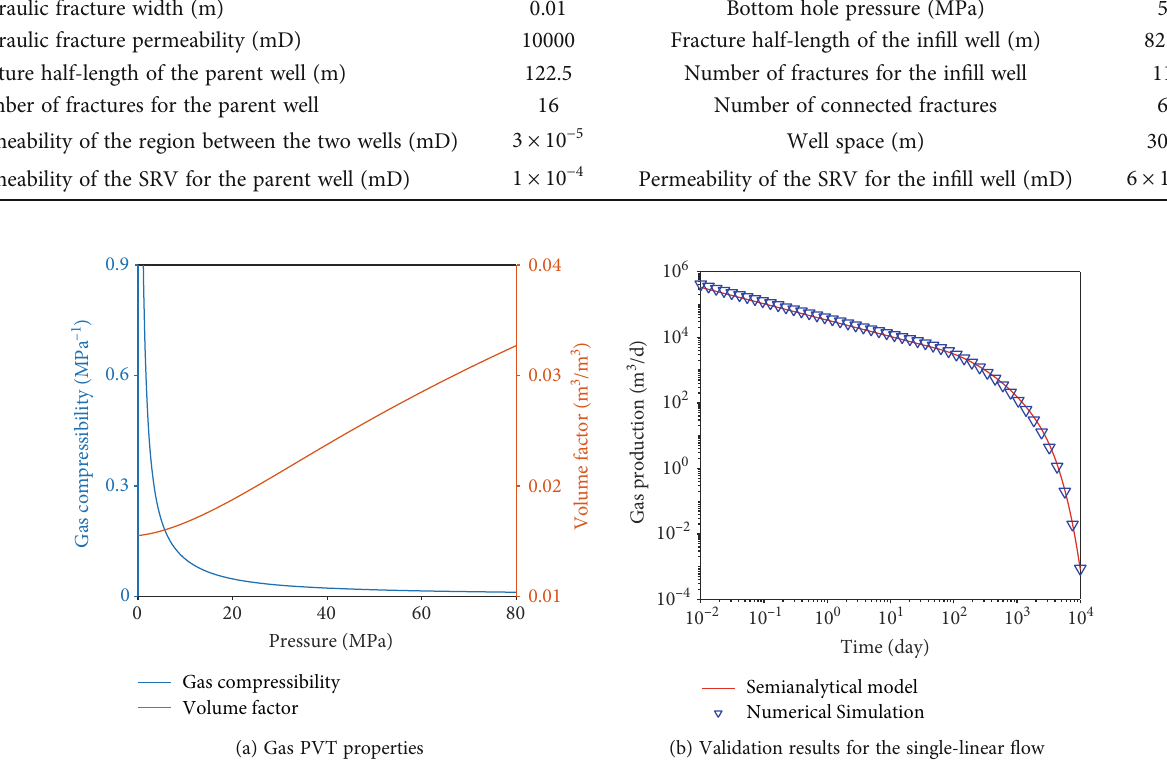
Figure 4: The procedure to predict the production for a single-linear fl ow